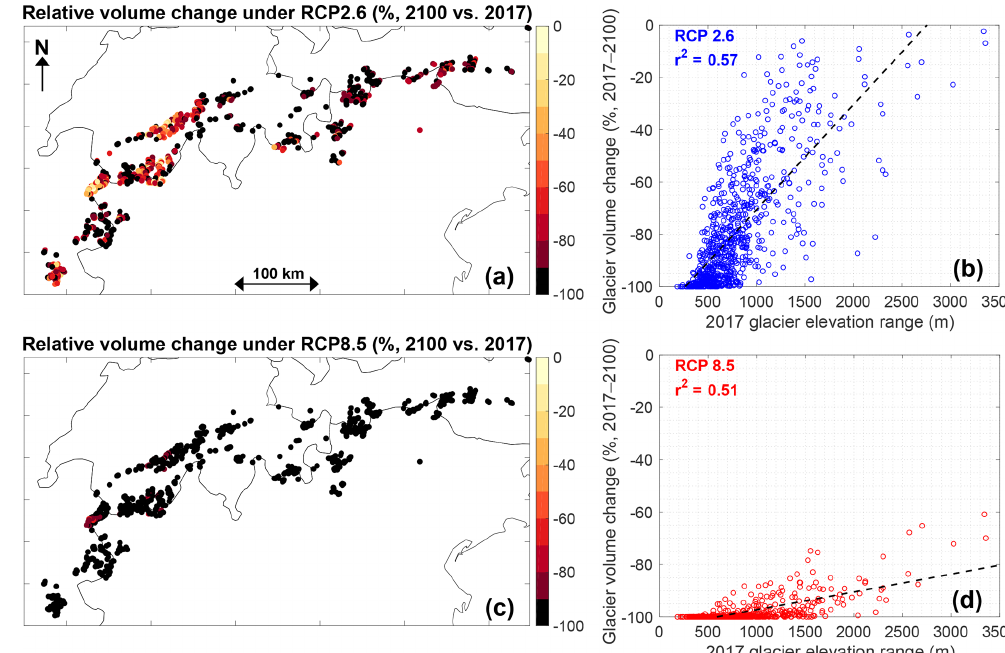
Figure 9. Relative volume changes between 2017 and 2100 under RCP2.6 (multi-model mean, a and b ) and a RCP8.5 (multi-model mean, c and d ). Results are shown for all 795 glaciers for which the future evolution is simulated with the dynamic model. Panels (b) and (d) represent the volume change as a function of the present-day glacier elevation range.